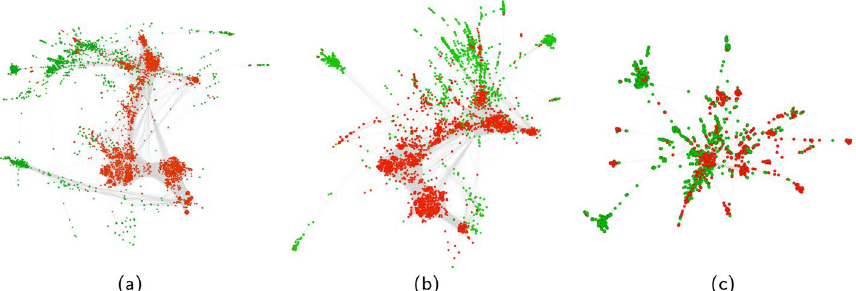
Fig. 9 Evolution of the largest component in the Honduras user-hashtag bipartite network for successive removal of highest degree hashtags (note that the original largest component has a size of 3035 nodes). a